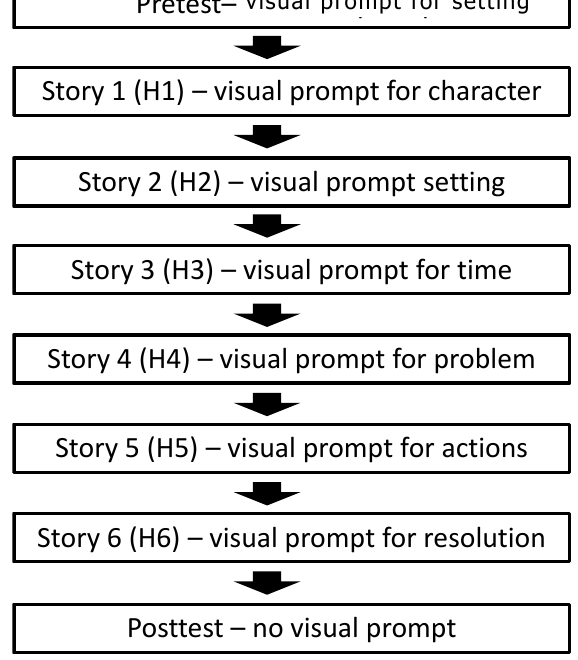
Figure 1. Presence or absence of picture prompts in each